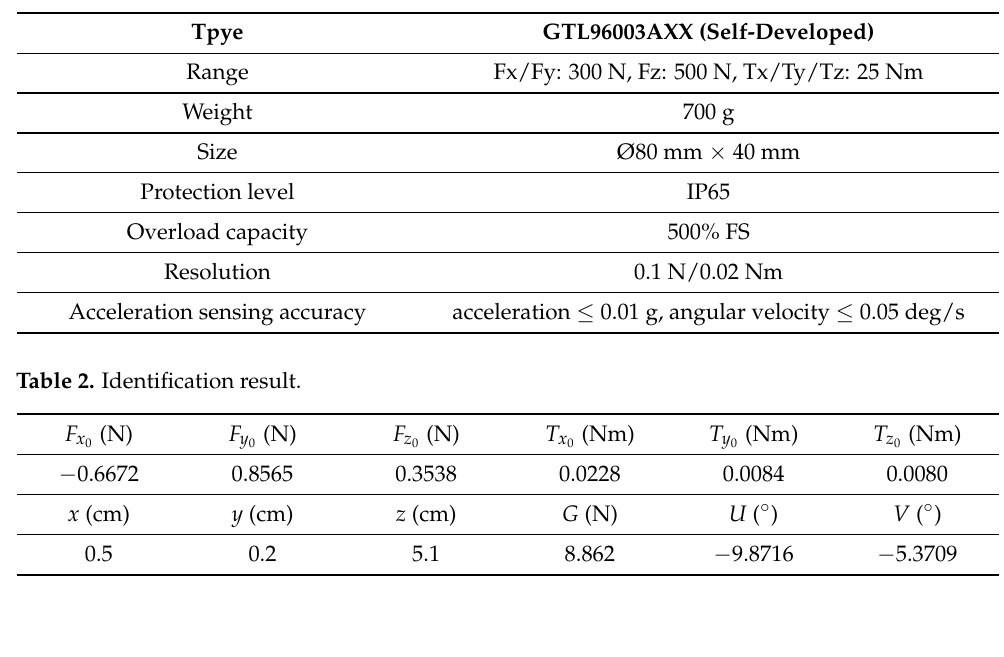
Table 1. The characteristic information of the sensor.